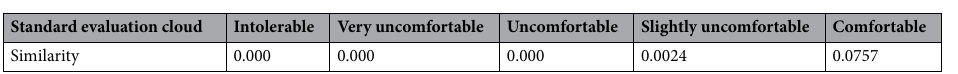
Table 3. Similarity between integrated evaluation cloud and standard evaluation cloud.